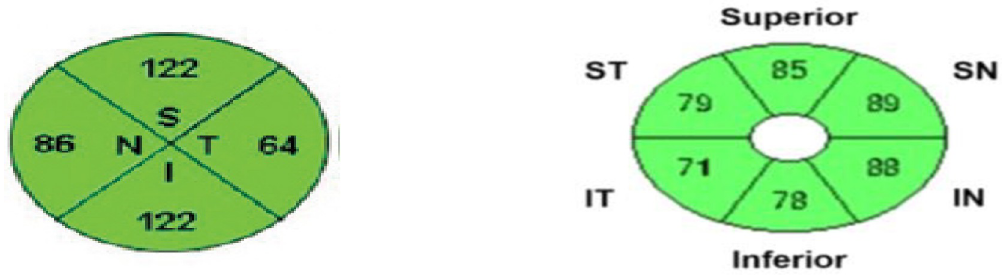
Fig 1. Representative OCT image of peripapillary RNFL in four quadrants (left) & macular GCIPL in six quadrants (right). N- nasal, S- superior, T-temporal, I- inferior, ST- superotemporal, SN- superonasal, IT- inferotemporal & IN-